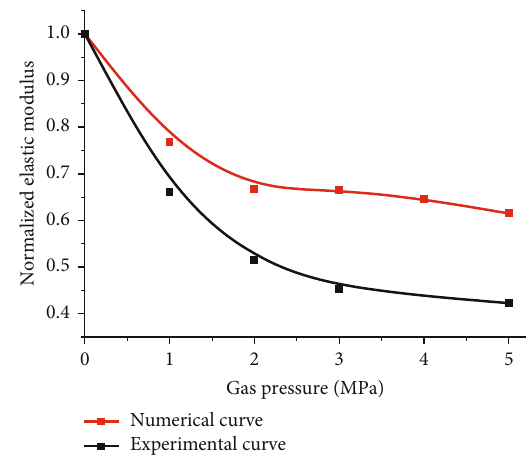
Figure 6: Variation of normalized elastic modulus of coal sample with gas